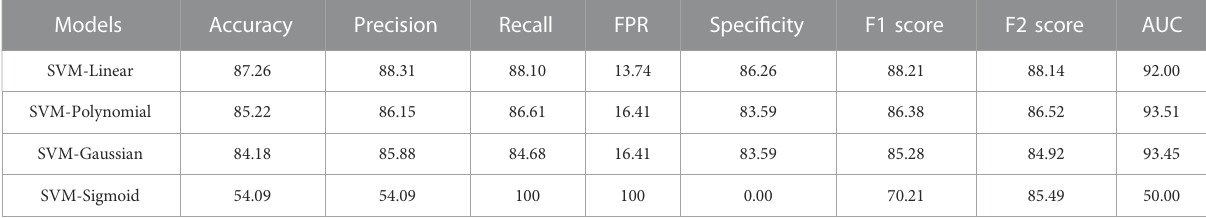
TABLE 4 Comparison of developed SVM models performance based on evaluation parameters ( fi gures in percentage). Models Accuracy Precision